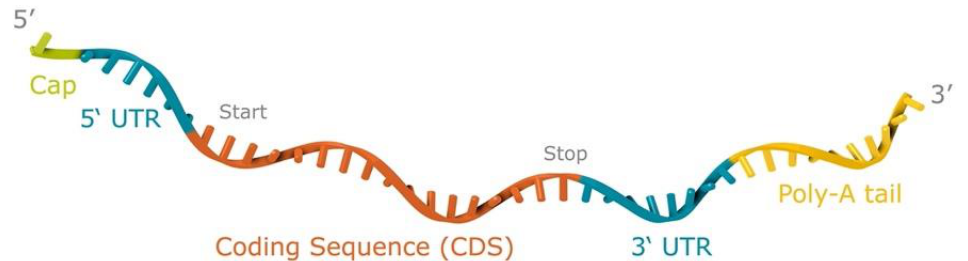
Figure 1. Schematic outline of the ZIKV prM–E mRNA-LNP vaccine candidate construct. Reprinted